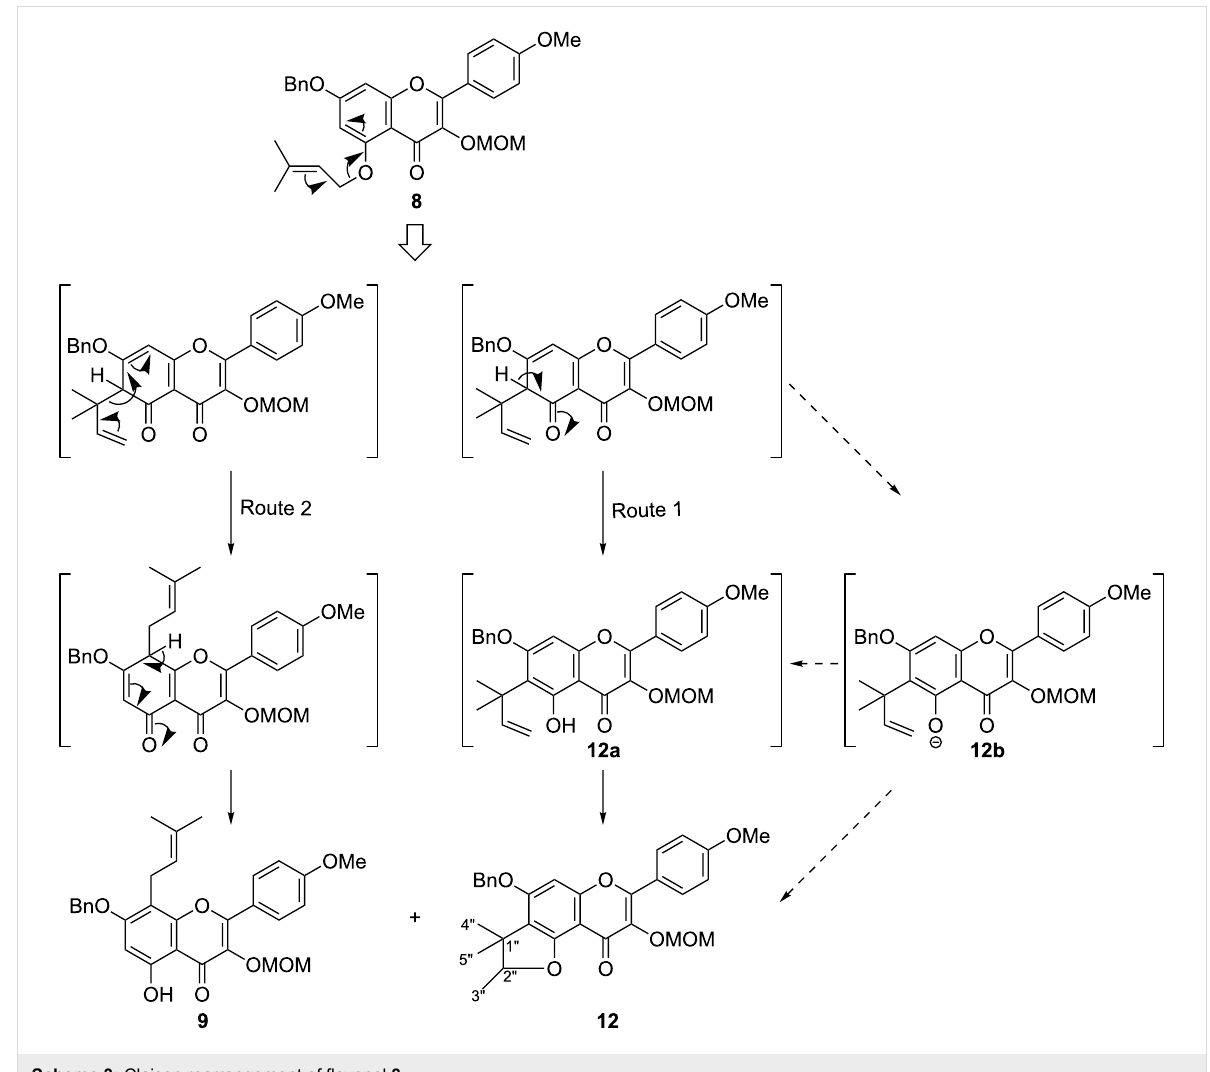
Scheme 3: Claisen rearrangement of flavonol 8